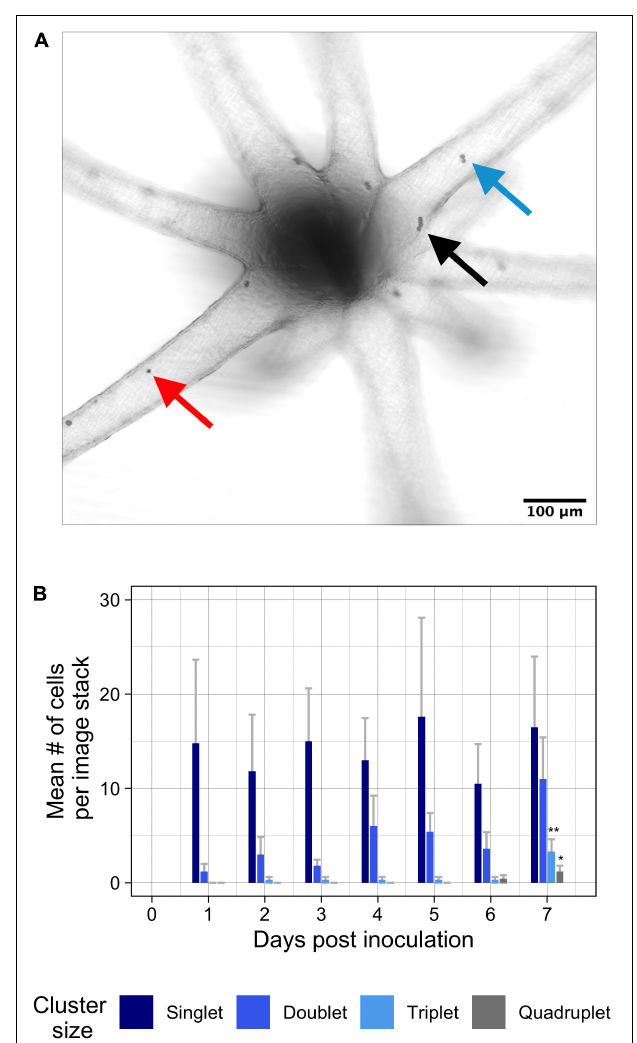
FIGURE 2 | Colonization by B. minutum over 1 week at 26 ◦ C. (A) Colonizing symbionts were tracked within the tentacles of tiny Aiptasia polyps with the genetic host strain background of H2 ( n = 7 anemones). For each day, one brightfield confocal z-stack per anemone was used to capture all information between the focal planes of the closest and furthest tissue. Clusters of symbiont cells were identified over a period of 7 days. (B) The cluster sizes of singlets (red arrow), doublets (blue arrow), triplets (not shown) and quadruplets (black arrow) were summarized within tentacles to find mean abundances of cells per cluster size over time. Aiptasia were inoculated with a concentration of 1 × 10 4 cells • mL − 1 . Error bars signify standard error. Asterisks represent statistically significant differences after ANOVA and Tukey post hoc test: ∗∗ p < 0.005 for triplets at 7 days compared to all other days; ∗ p < 0.05 for quadruplets at 7 days compared to days